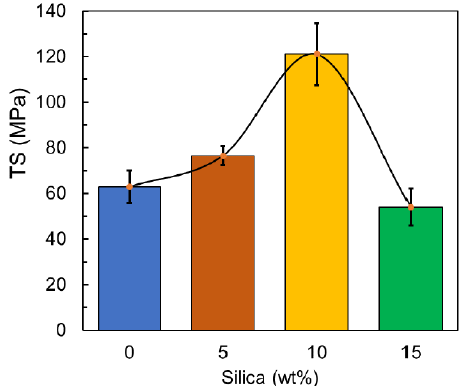
Figure 11. Tensile Strength values of the prepared material .